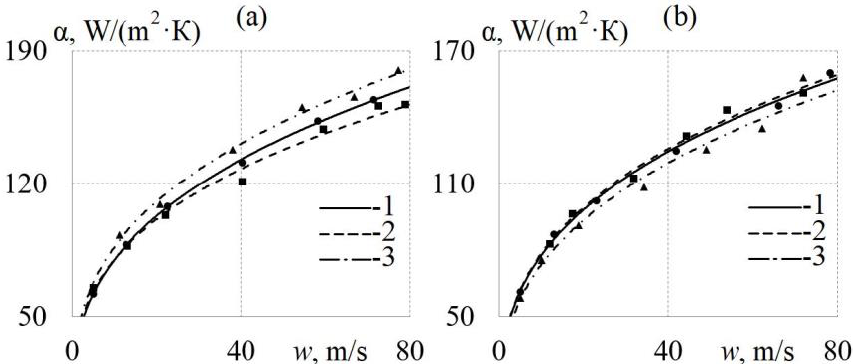
Figure 8. Dependences of the local heat transfer coefficient α on the average air velocity w in round (1), square (2), and triangular (3) pipes without a turbulator (average TI = 0.02) for different control sections: ( а ) l x = 100 mm; ( b ) l x = 300 mm.